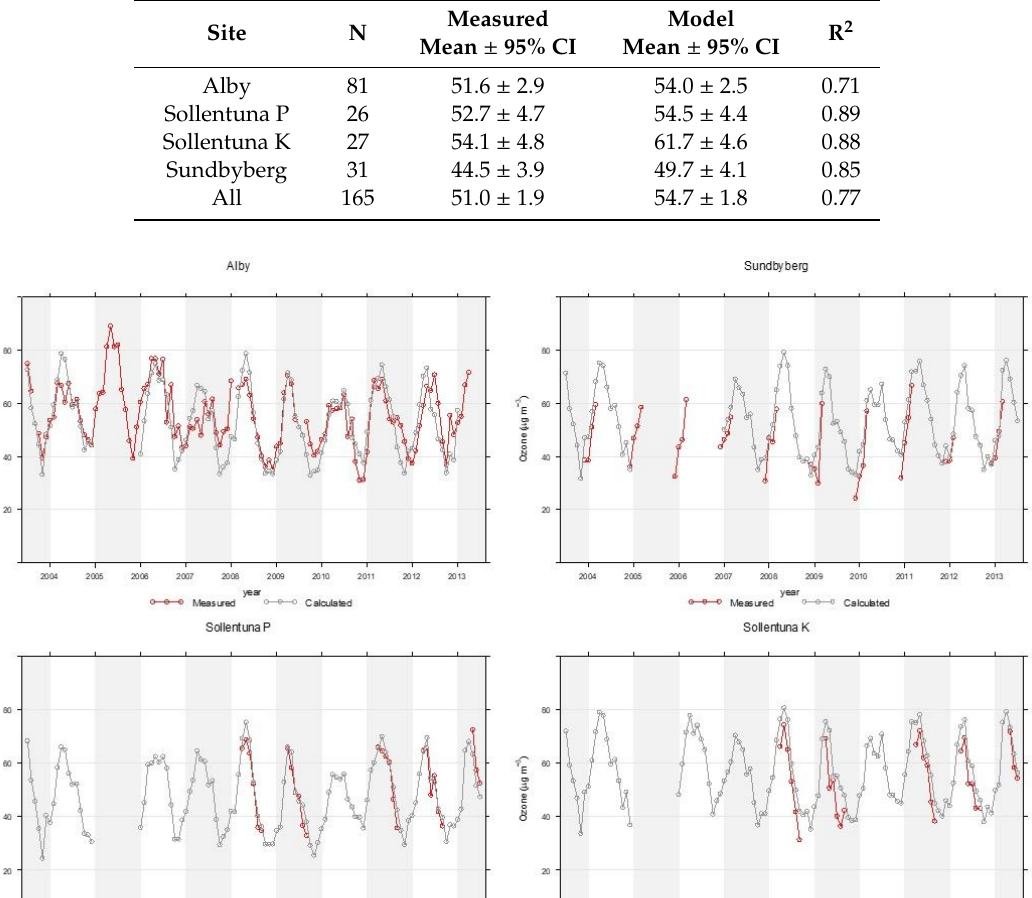
Table A1. Mean measured and modelled ozone concentrations at four sites. The confidence intervals are based on monthly mean concentrations.